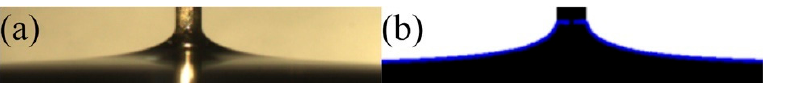
Figure 2. ( a ) An example of an image of a receding meniscus (1 g/dL polyvinyl butyral, 100 µm/s); ( b ) The best fit of the meniscus profile by Equation (2) (( left part ): 15°, ( right part ) 18°).